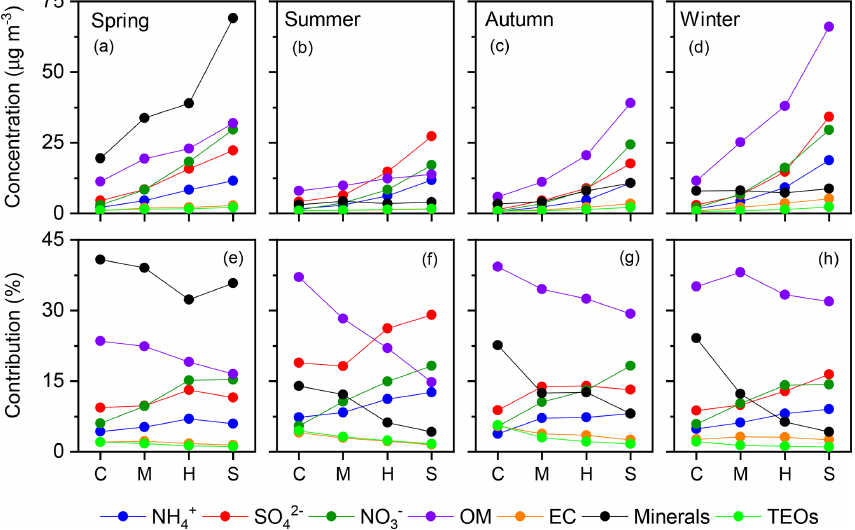
Figure 10. Variations in the mean concentrations (upper panels) and contributions (lower panels) of the seven major known components of PM 2 . 5 with pollution levels in each season. C, clean; M, moderate pollution; H, heavy pollution; S, severe